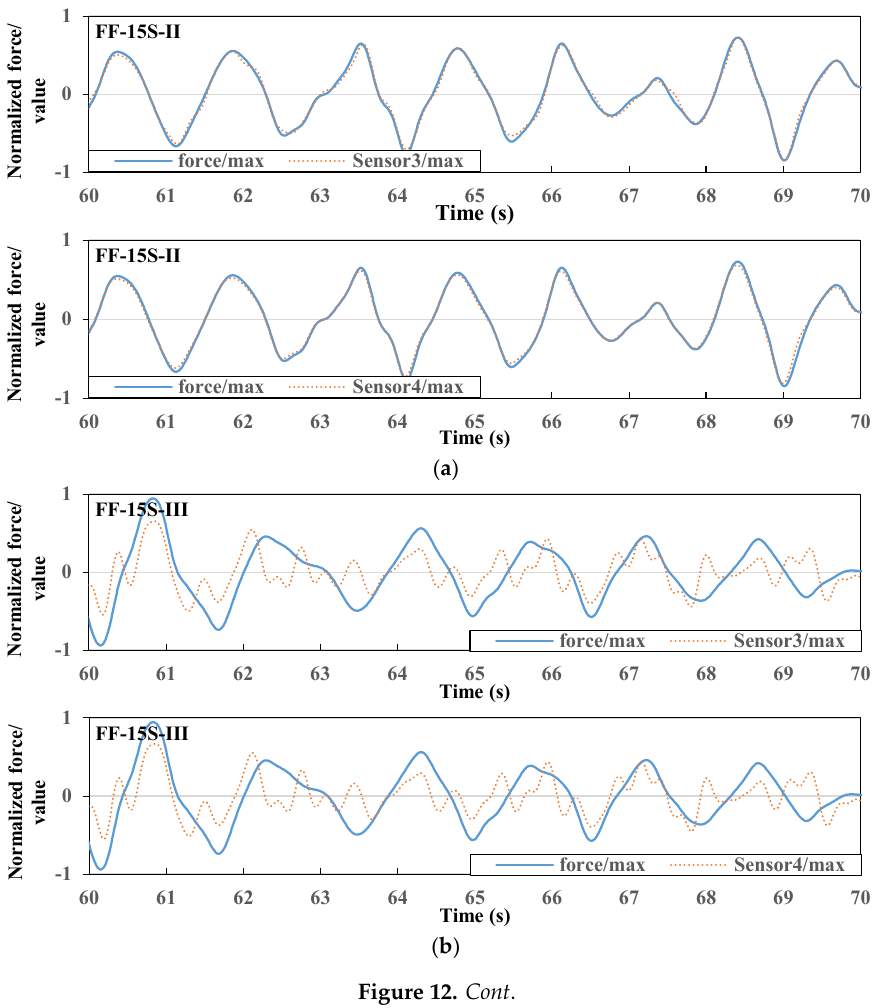
Figure 11. The waveform comparison between the sensor signals and applied force of specimens. ( a ) FF-15S-II (Sensor 3 and Sensor 4); ( b ) FF-15S-III (Sensor 3 and Sensor 4); ( c ) FF-15S-IV (Sensor 3 and Sensor 4); ( d ) FSF-15S-II (Sensor 3 and Sensor 4); ( e ) FSF-15S-III (Sensor 3 and Sensor 4); ( f ) FSF-15S-IV (Sensor 3 and Sensor 4); ( g ) SF-30S-II (Sensor 3 and Sensor 4); ( h ) SF-30S-III (Sensor 3 and Sensor 4).